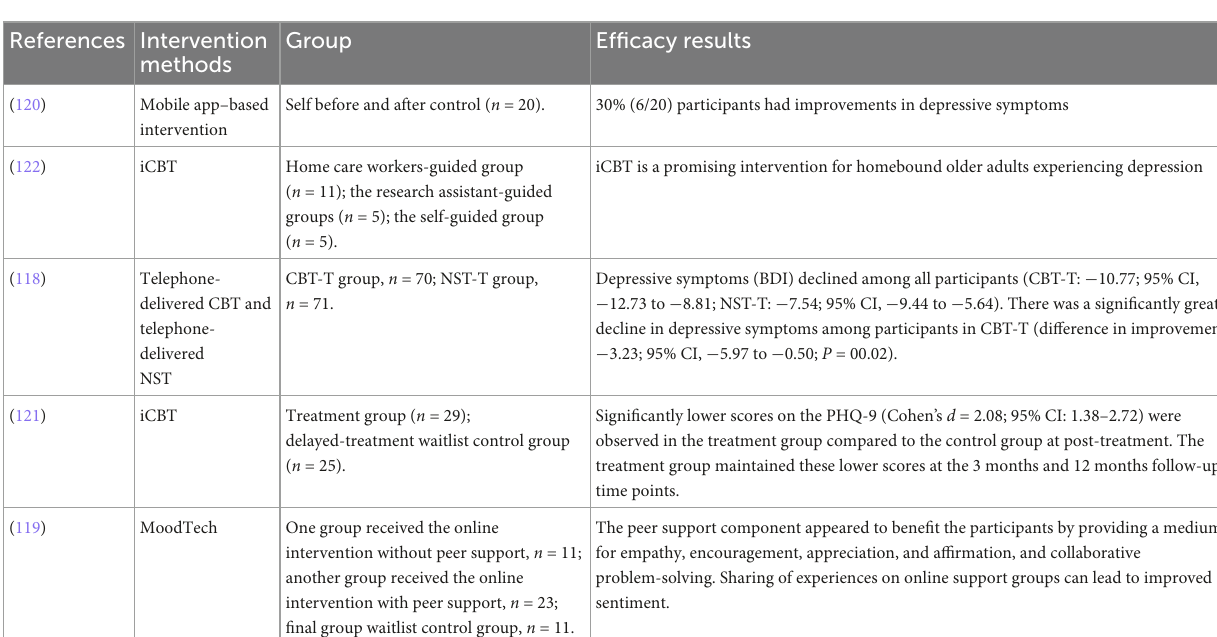
TABLE 2 Digit-based treatment of